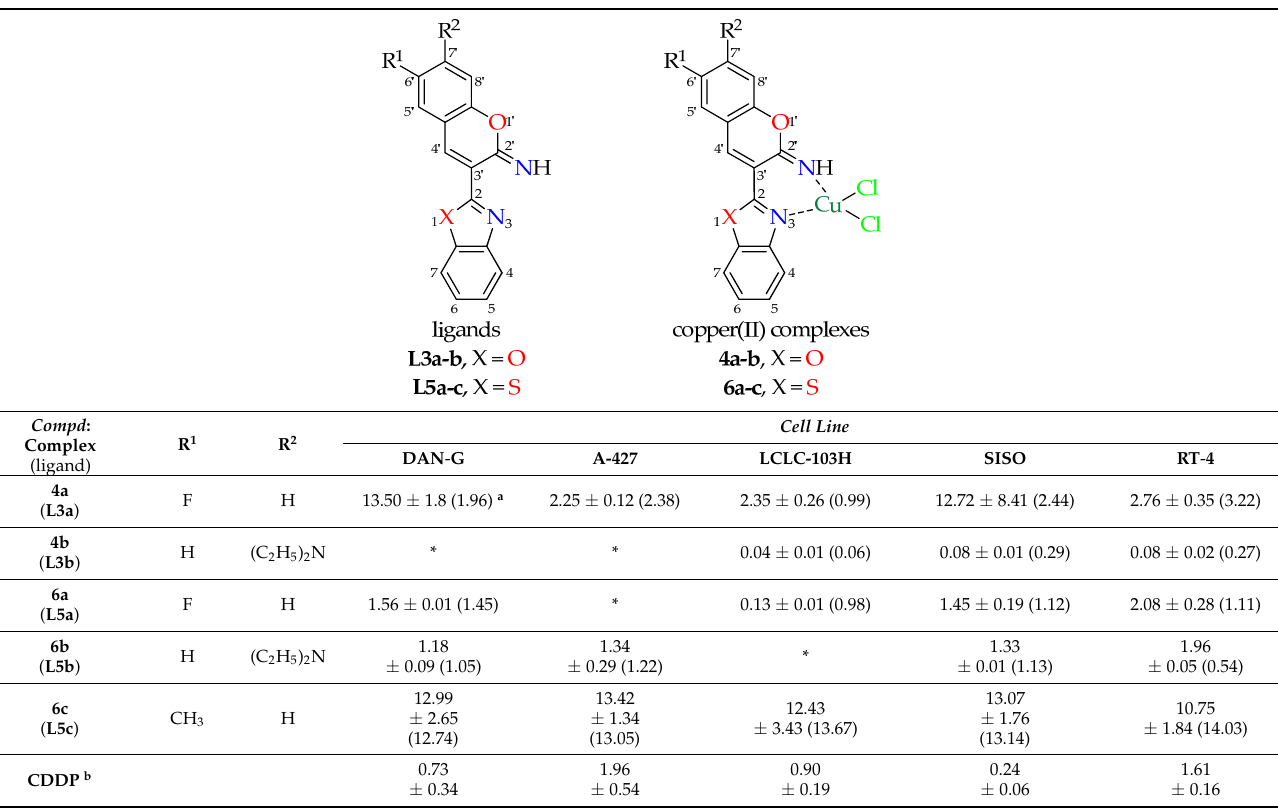
Table 2. IC 50 ( µ M) values of copper(II) complexes of 3-(benzoxazol-2-yl)-2 H -chromen-2-imines 4a - b , and 3-(benzothiazol-2-yl)-2 H -chromen-2-imines 6a - c , their corresponding ligands L3a-b , L5a-b, and reference compounds in five human cancer cell lines after 96 h a .